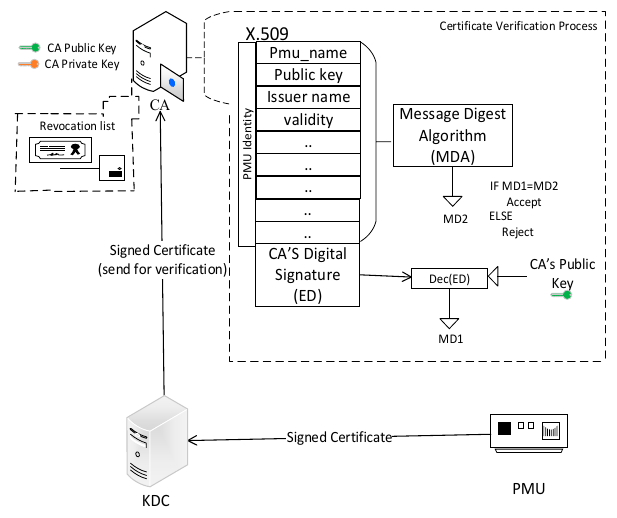
Figure 9. Certificate verification by CA.